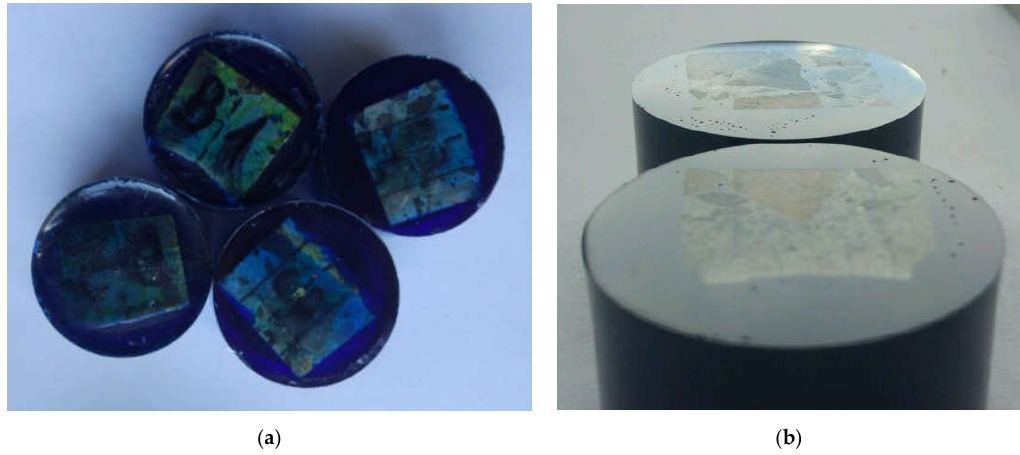
Figure 18. Samples for testing in nanoindenter: ( a ) samples embedded in epoxy resin; and ( b ) samples with surface polished for testing.